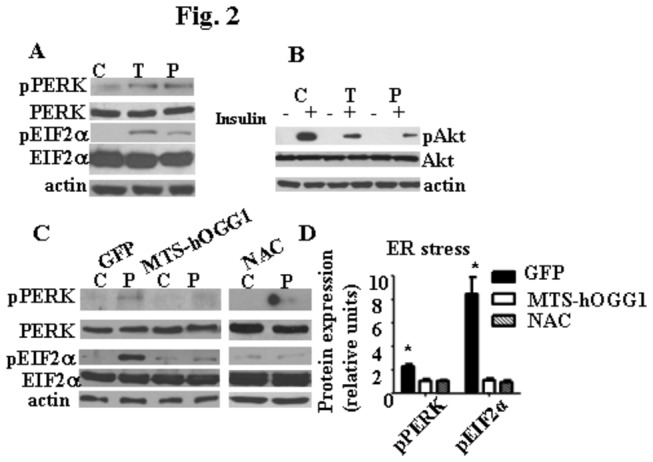
Mitochondrial hOGG1 protected against ER stress.Treatment of L6 myotubes with 1 mM of palmitate (P) or 5 μg/ml of tunicamycin (T) for 24 h induced phosphorylation of both PERK and EIF2α (A). Treatment of L6 myotubes with tunicamycin (T) or palmitate (P) reduced insulin-stimulated phosphorylation of Akt (Ser473) (B). For both A and B, control medium (C, 2% BSA) was used. Targeting of hOGG1 to mitochondria in L6 myotubes ameliorated palmitate-mediated activation of ER stress markers. MTS-hOGG1 or GFP transduced L6 myotubes were exposed to control medium (C, 2% BSA) or medium containing 1 mM palmitate (P) for 24 h (C and D). Total cell lysates were isolated and analyzed by Western blot analysis with the indicated antibodies. Representative blots (C) and values of densitometry data (D) from at least three independent experiments are shown. The values for densitometry are presented as fold induction over corresponding control data normalized to the actin level. In addition, for phosphorylated proteins, the values from densitometry from three independent experiments for each phosphorylated protein were normalized to the level of corresponding total protein, and expressed as fold induction over corresponding control data normalized to the actin level. (n > 3). *p < 0.05 vs all other groups.